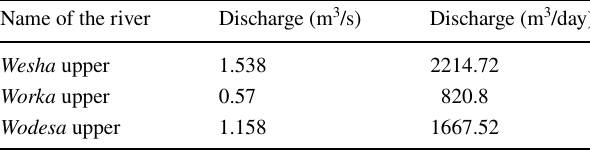
Fig. 1 Study area map by land use Table 1 Extent of land uses in Wondo Genet Watershed